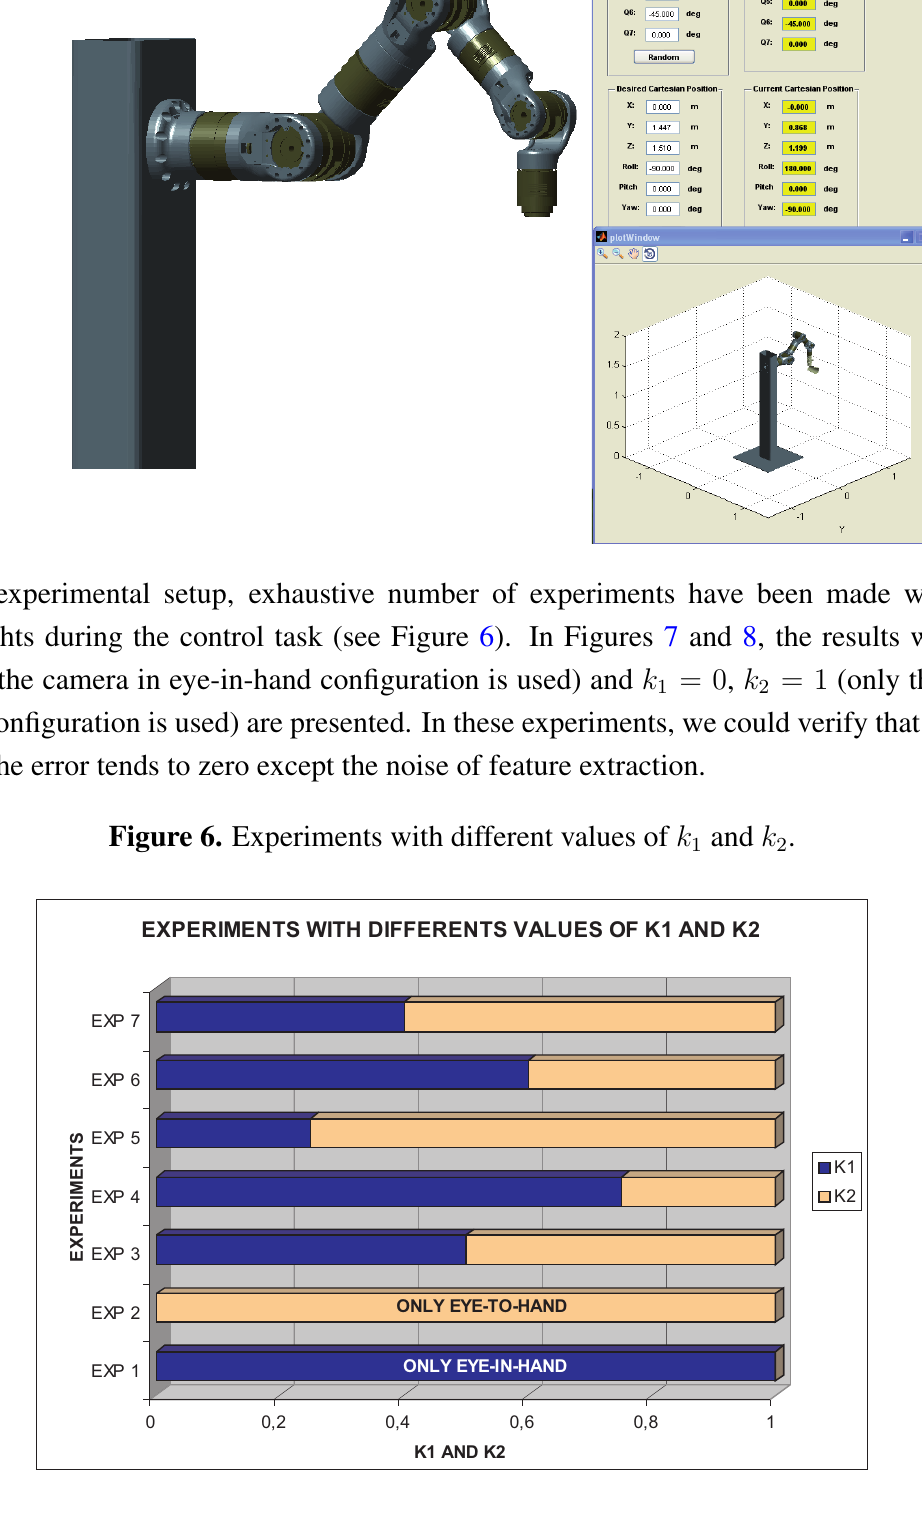
Figure 5. Images of the simulation environment implemented using Matlab and Simulink.